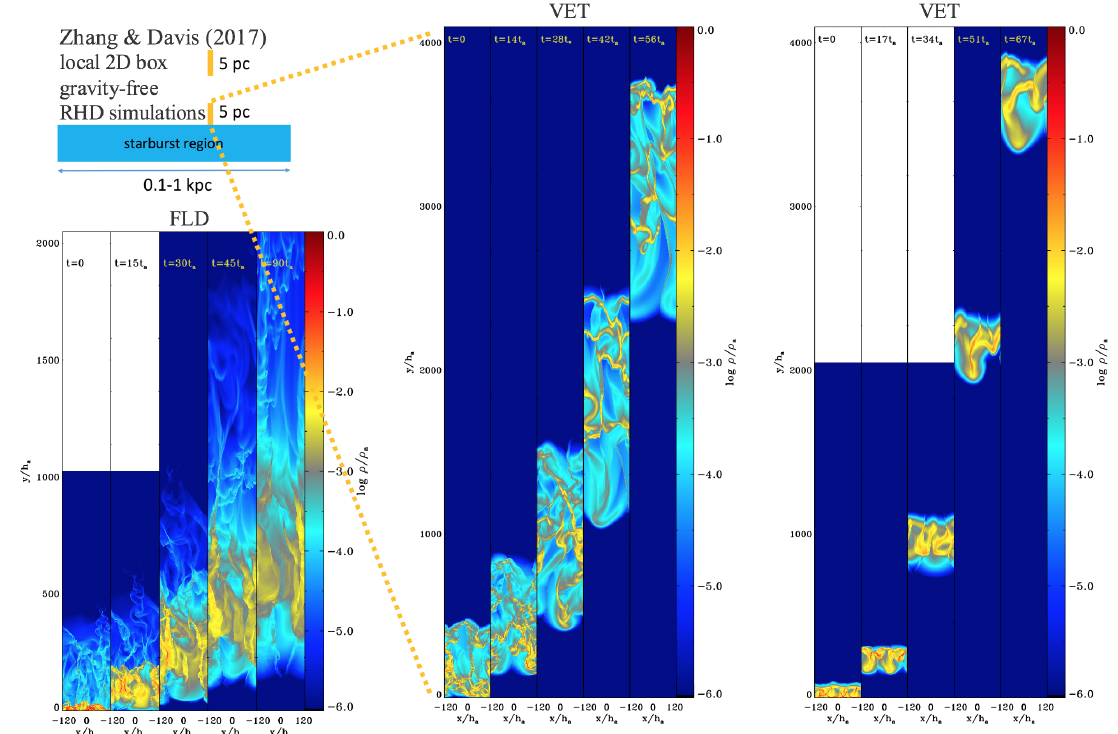
Figure 7. Density snapshots in 2D radiation hydrodynamic simulations of dusty shells accelerated by radiation pressure on dust using two algorithms: the flux-limited-diffusion (FLD) method ( left panel ), the VET method ( middle and right panels ). The initial IR optical depth for dust is τ IR = 3 ( left and middle panels ), and τ IR = 1 ( right panel ), with the same radiation field injected at the bottom boundaries. The FLD run shows that radiatively driven instability creates low-density channels and the dusty gas spreads out of the entire box. The VET runs show that the dusty gas is still accelerated as a whole with more IR flux trapped in the gas, and more efficient momentum coupling between radiation and gas than that in the FLD